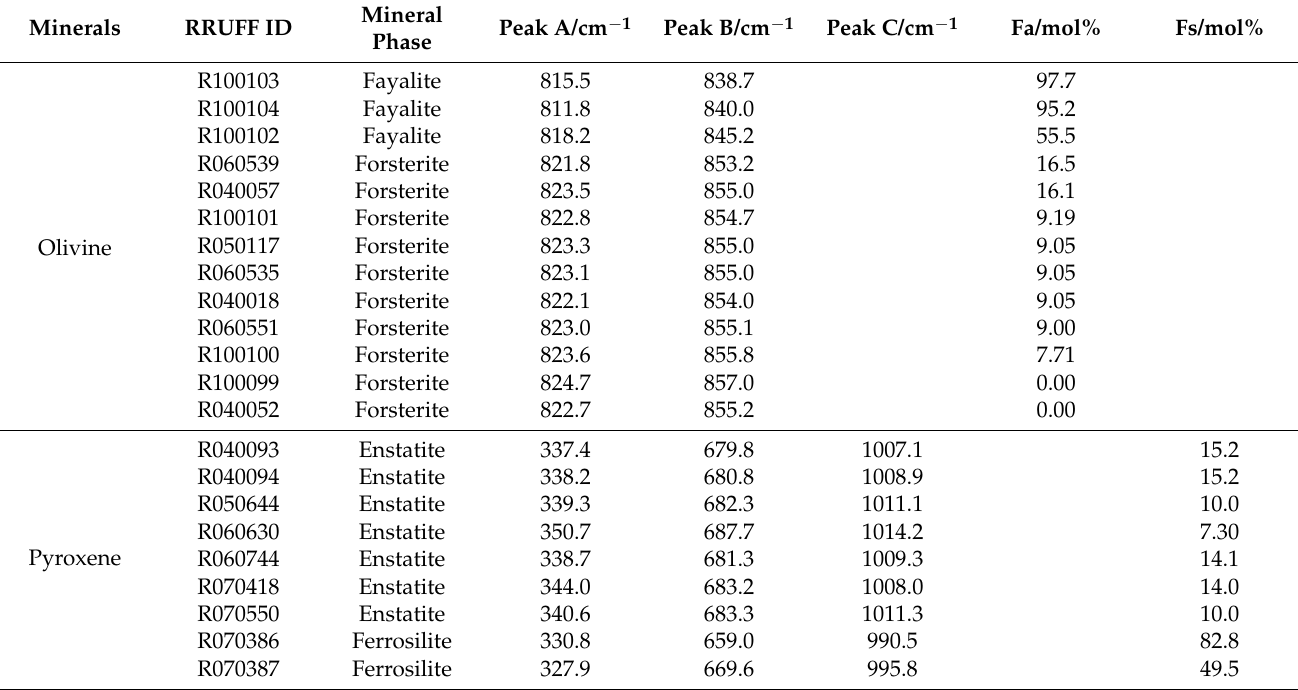
Table 2. Raman shift of selected minerals (raw data provided by the online database